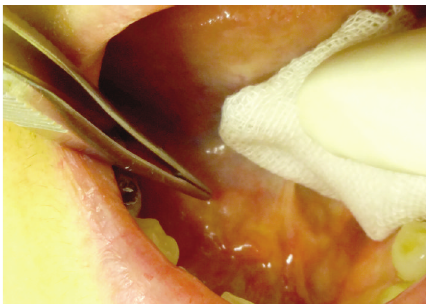
Figure 3: Clinical findings of Case 2. A small mass on the left side of the floor of the mouth (arrows). The mass was slightly red.